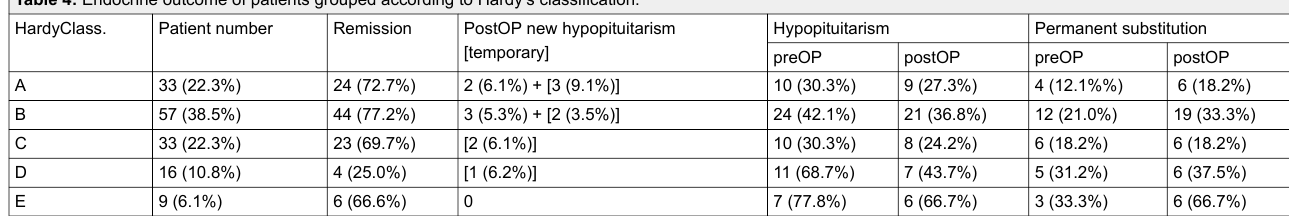
Table 4: Endocrine outcome of patients grouped according to Hardy’s classification.